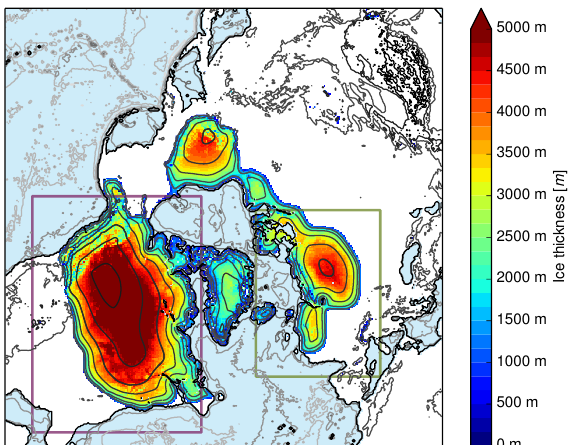
Figure 12. Hysteresis after 3.75million years at LGM tempera- ture ( (cid:49) 0 ◦ C) with an ice volume of 236.7ms . l . e . The situation at the same temperature at the build-up process of the ice sheet after 1.25million years can be seen in Fig. 9 (left). Areas of North Amer- ica and Eurasia from Fig. 11c and d are enclosed in purple and green boxes,